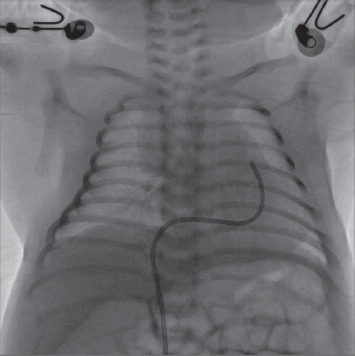
The Simmons catheter was maneuvered directly into the RVOT (anteroposterior view).